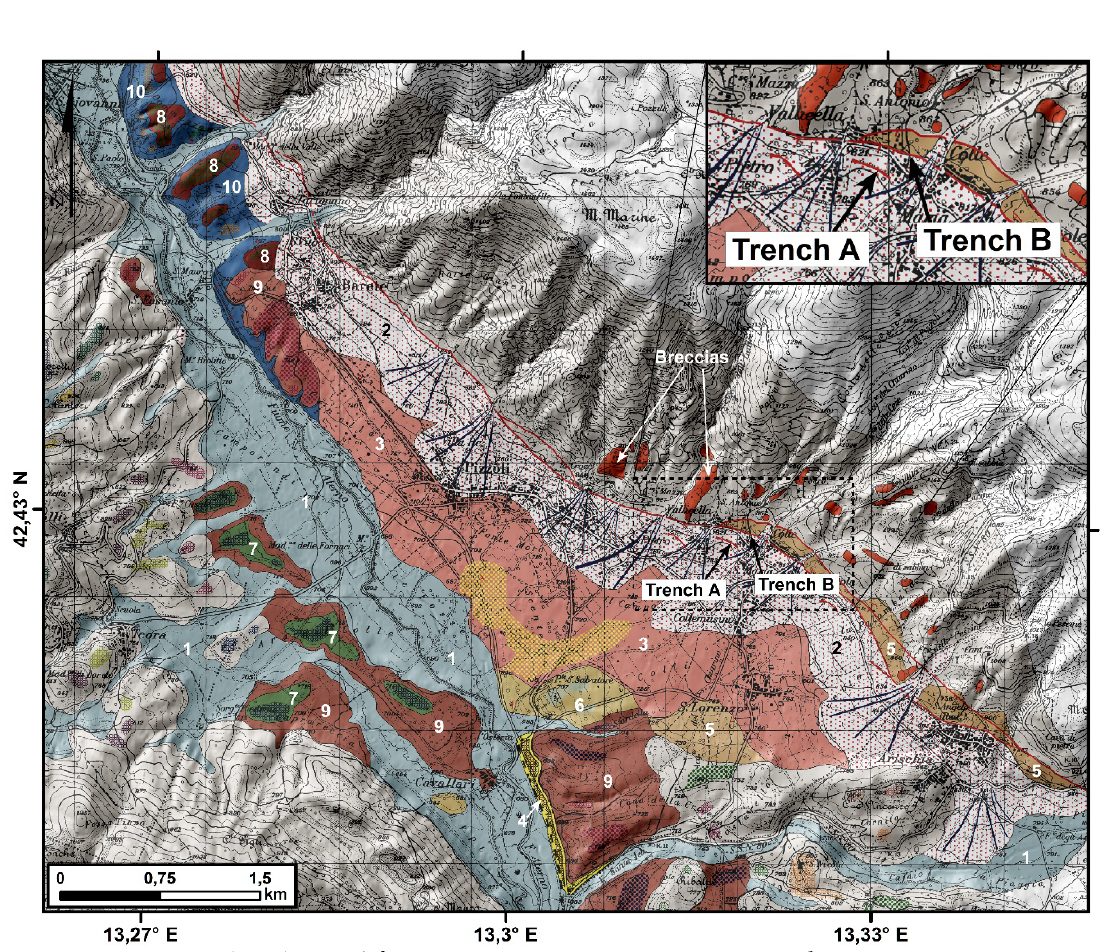
Fig. 3: Quaternary geological map of the Upper Aterno basin modified after Bosi et al., 2004. Legend: 1) sandy- silty and alluvial deposits (Holocene); 2) colluvial and slope deposits (Upper Pleistocene-Holocene); 3) gravels, silt and clay (Upper Pleistocene-Holocene); 4) alluvial and gravel deposits (Upper Pleistocene-Holocene); 5) alluvial uvial deposits (Upper Pleistocene-Holocene); 6) alluvial gravel deposits (Upper Pleistocene-Holocene); 7) sandy- silty alluvial deposits (Upper Pleistocene-Holocene); 8) silty-sandy alluvial deposits (Middle Pleistocene); 9) allu- vial gravels (Middle Pleistocene); 10) gravel and sand al- luvial deposits (Upper Pliocene). Grey color represent the bedrock units. Dots polygons represent the depositional and erosional paleosurfaces associated with the under- lying deposits. The inset represent a magnification show- ing the trench